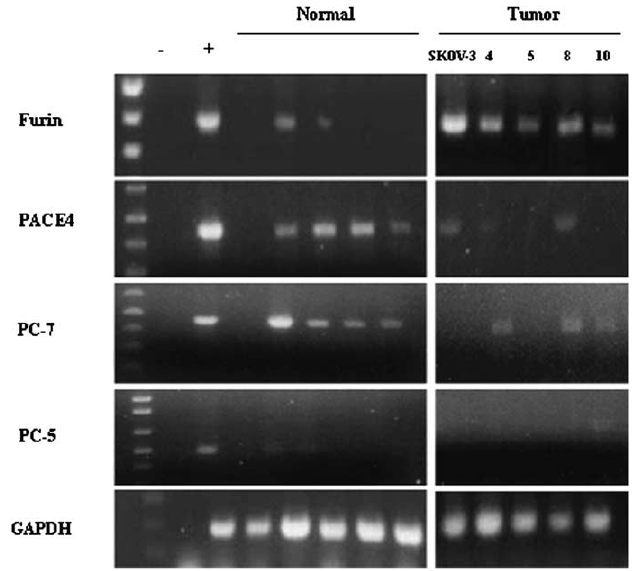
Fig. 1. PC’s expression in normal or cancer cell lines. DNAase-treated RNA (100 ng) from five normal and five cancer cell lines were amplified by RT-PCR using specific primers for the ubiquitously expressed PCs, furin, PACE-4, PC-5, and PC-7. GAPDH amplification was used as loading controls. Note that PACE-4 and PC-5 are strongly expressed in the normal cells. In contrast furin expression is higher in cancer cells.